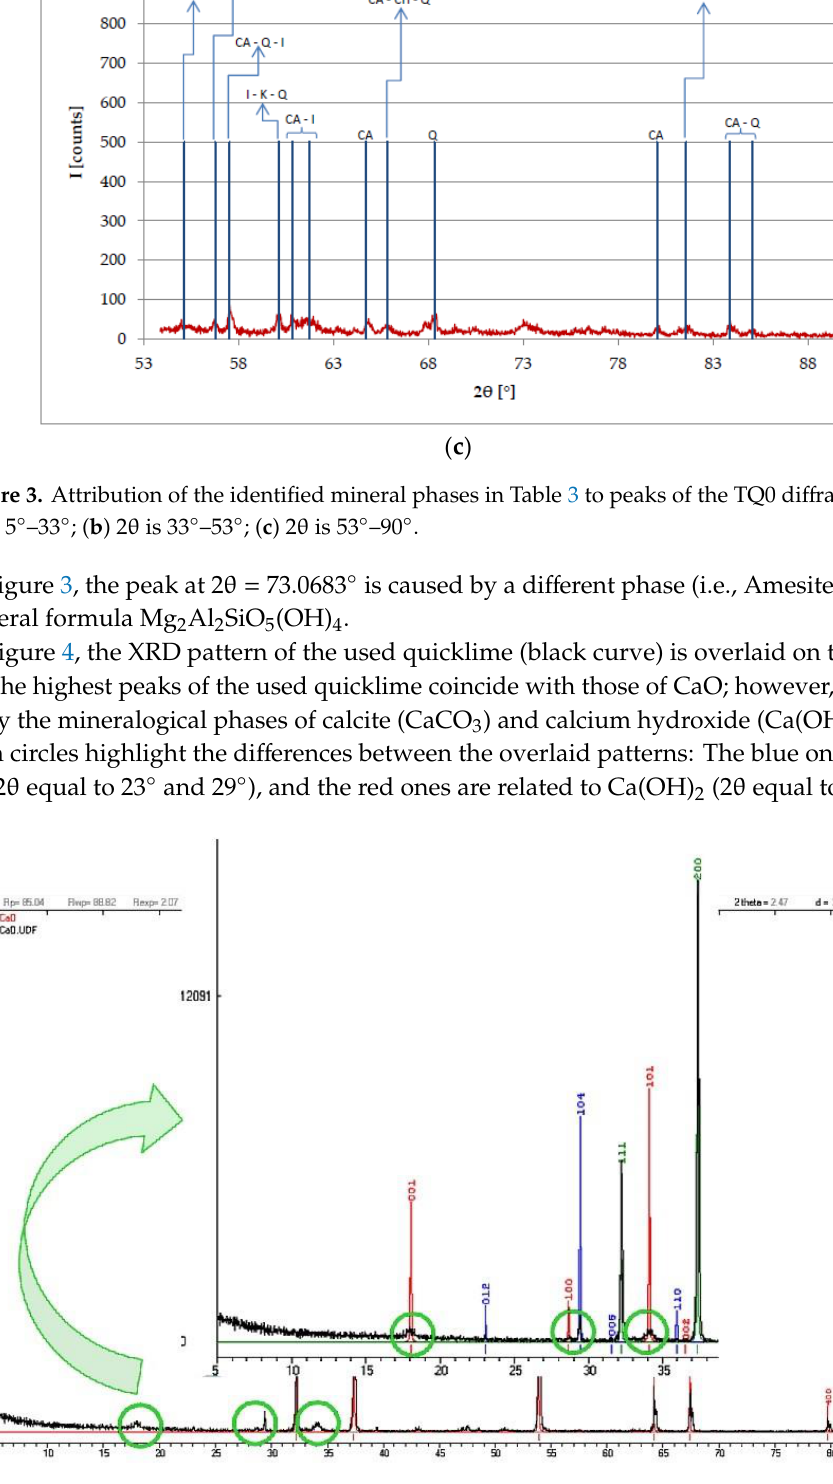
Figure 4. Differences between the quicklime diffractogram (black curve) and the CaO diffractogram (red curve).